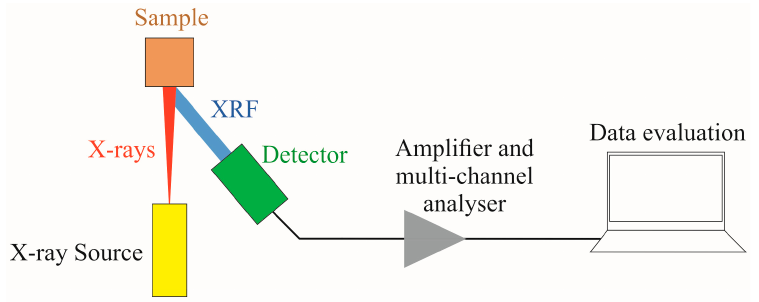
Figure 3. X-ray fluorescence (XRF) spectra measurement